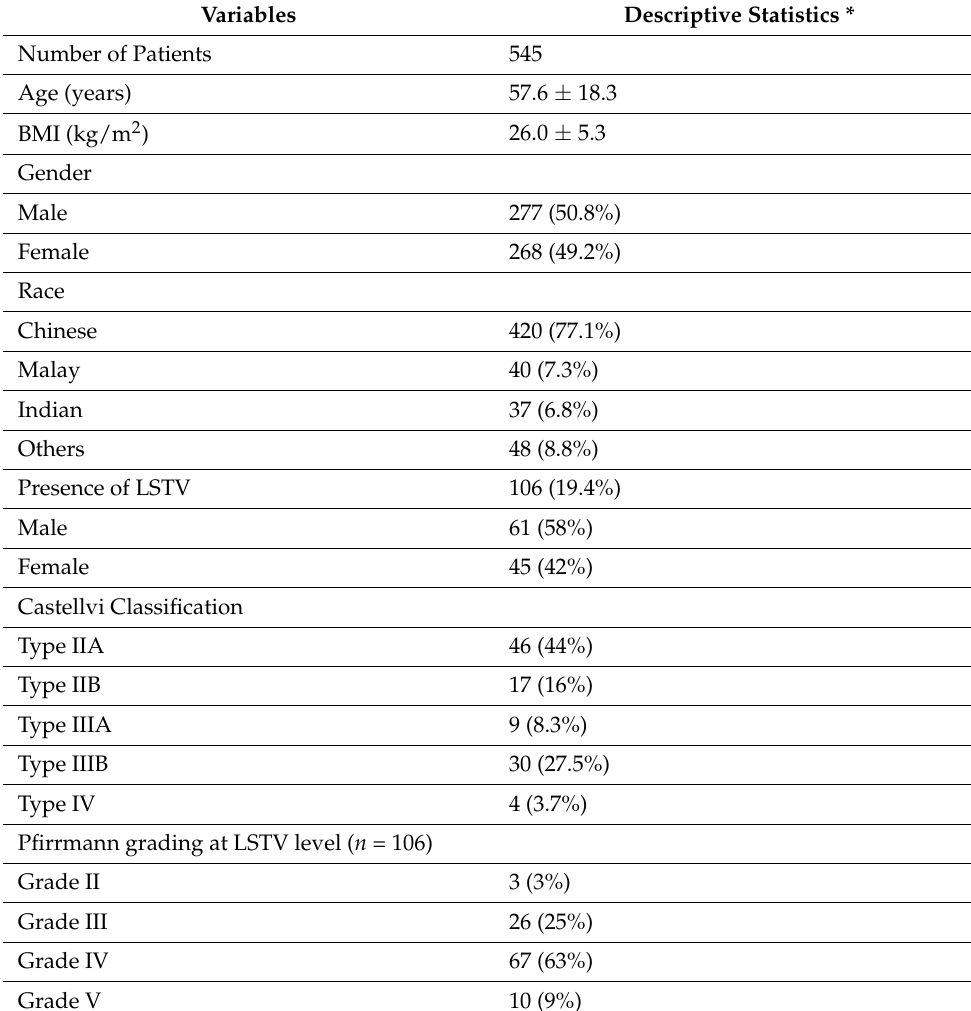
Table 1. Baseline characteristics of